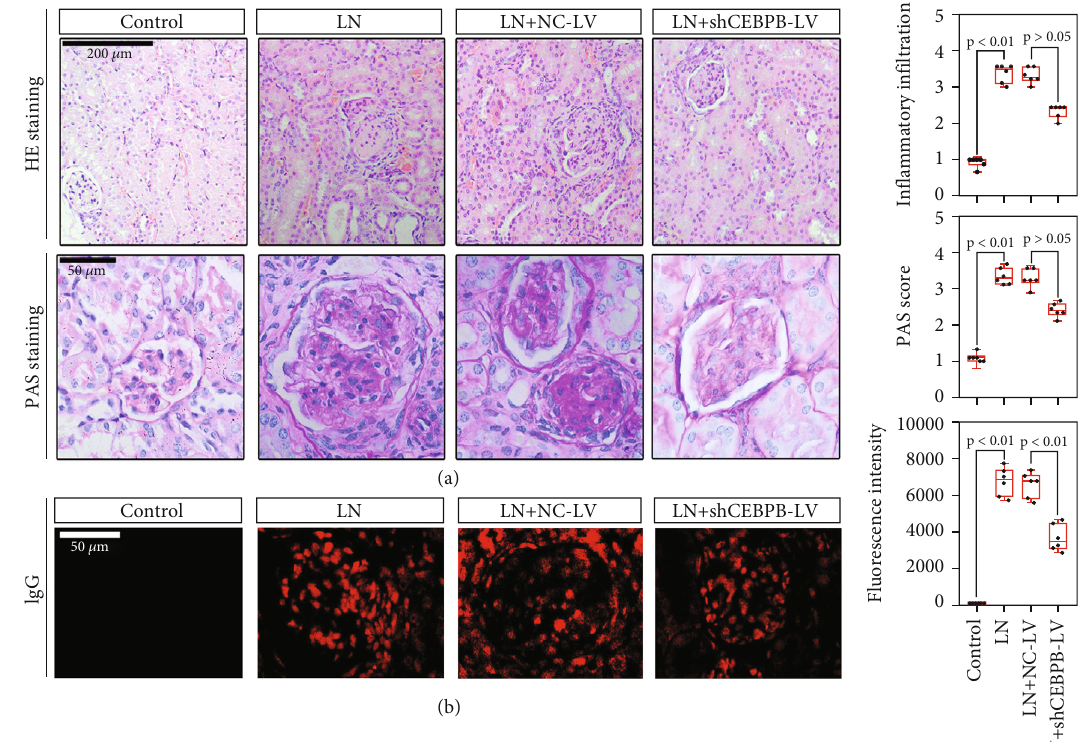
Figure 3: The knockdown of CEBPB alleviated the kidney damage on histopathology in MRL/lpr mice. Representative images of H&E (200 μ m) and PAS (50 μ m) staining (a) and immuno fl uorescence detection of IgG (50 μ m) (b) of kidney tissues in CEBPB- downregulated MRL/lpr mice. (CEBPB, CCAAT/enhancer-binding protein β ; H&E, hematoxylin-eosin; PAS, Periodic Acid-Schi ff